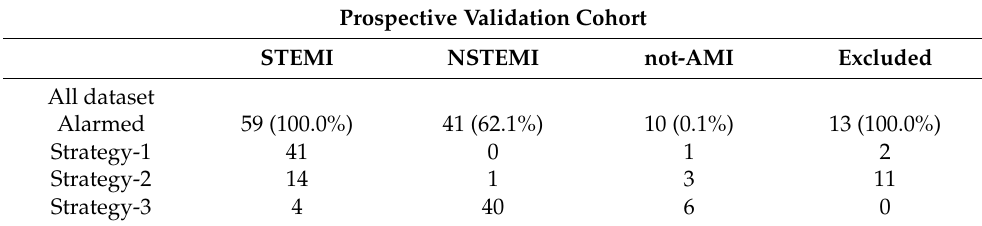
Table 1. The performance of acute myocardial infarction detection by an AI-based alarm strategy in the prospective validation